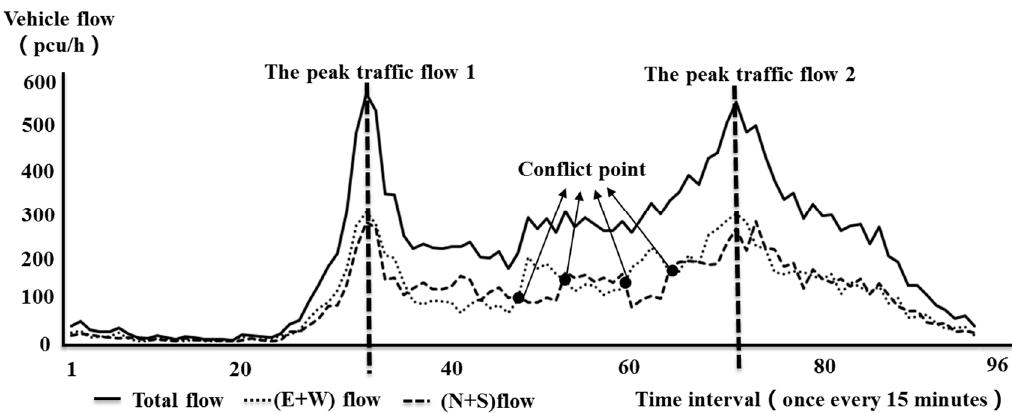
Figure 1. Distribution chart of total and fractional flows of each direction (intersection of Yangming North Road and Renmin East Road, Yuecheng District, Shaoxing City on 23 June 2016).